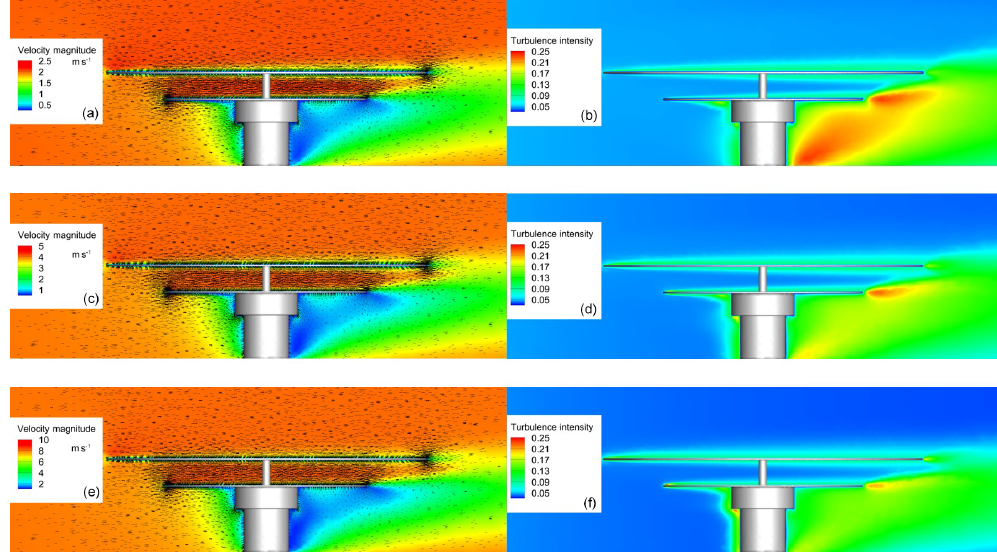
Figure 4. Flat-plate sampler: velocity magnitude and turbulence intensity at wind speed of 2ms − 1 (a, b) , flat-plate sampler: velocity magnitude and turbulence intensity at wind speed of 4ms − 1 (c, d) , flat-plate sampler: velocity magnitude and turbulence intensity at wind speed of 8ms − 1 (e, f) . Table 2. The campaign maximum, minimum and median mass deposition rates measured by the